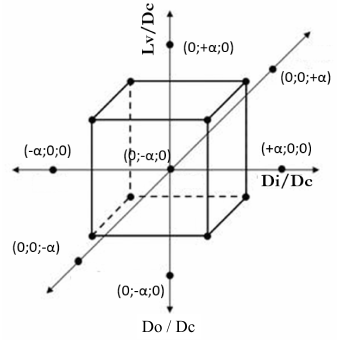
Figure 9. Design Figure 9. Design cube.